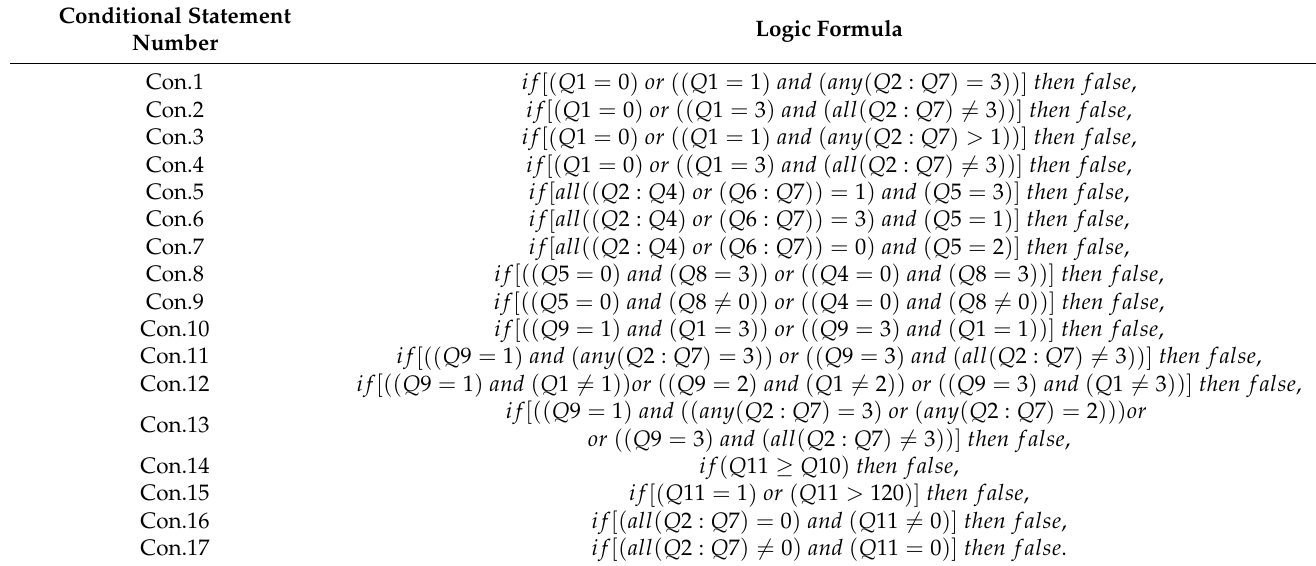
Table 1. Conditional (Con.) statements, the basis of the quality assurance (QA) mechanisms.